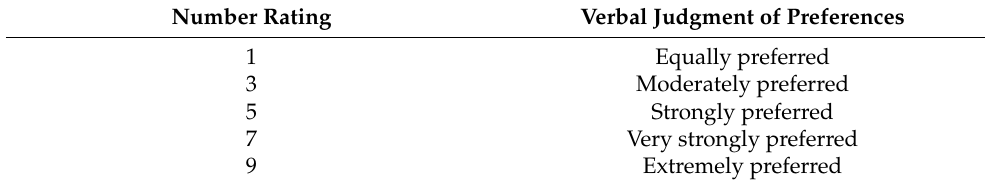
Table 4. A fundamental 1 to 9 scale.